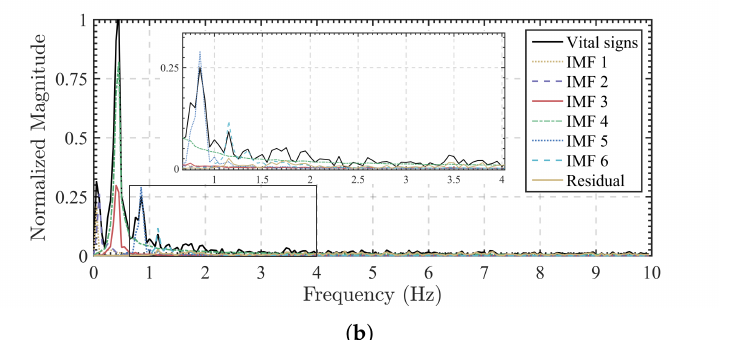
Figure 10. Vital signs signal (Subject 1) decomposited by VMD. ( a ) The IMFs. ( b ) Spectrums of the